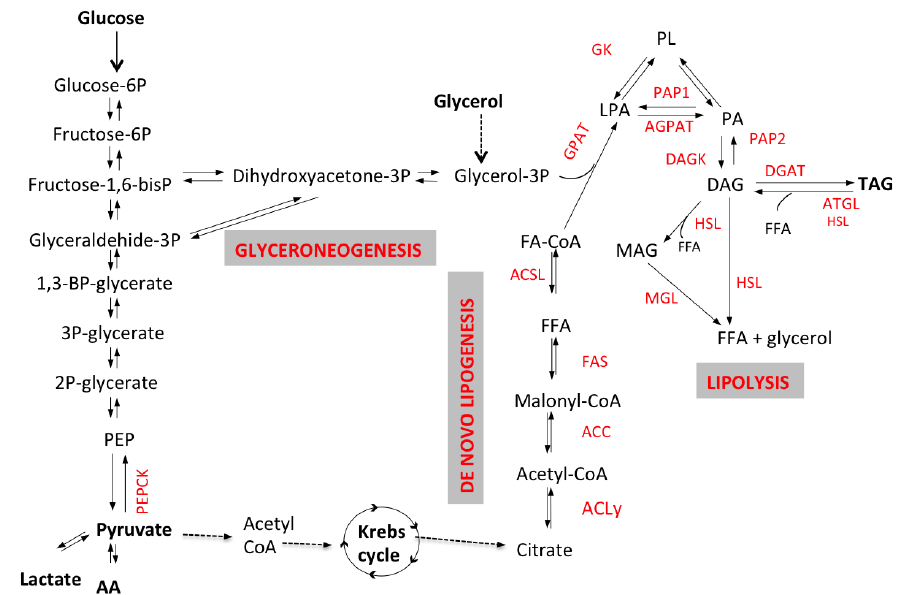
Figure 1. Schematic representation of lipolytic and lipogenic pathways. Triacyglycerol (TAG) synthesis requires the activation of free fatty acids (FFA) into Acyl-CoA by enzyme acyl-CoA synthetase. FFA-CoA and G3P are transformed via acylation, by glycerol-3-phosphate acyltransferase (GPAT) and acylCoA acylglycerol-3-phosphate acyltransferases (AGPAT), to phosphatidic acid (PA); then, after a dephosphorylation by phosphohydrolase (PAP2), diacylglycerols (DAG) are formed. Diacylglycerol acyltransferase (DGAT) catalyzes the conversion of DAG into TAG. In the adipocyte, G3P might come either from glycolysis or from non-carbohydrate substrates via the enzyme phosphoenolpyruvate carboxykinase (PEPCK), through a process named glyceroneogenesis. In the liver G3P can also be synthesized from plasma glycerol. De novo fatty acids synthesis (also referred to as de novo lipogenesis or DNL) occurs in the cytoplasm of various cells (e.g., adipocytes and hepatocytes) where citric acid is converted to acetyl-CoA by ATP-citrate lyase (ACL) and subsequently to malonyl-CoA by acetyl-CoA carboxylase (ACC). DNL occurs mainly in the liver, but it might occur in adipose tissue as well, although with low rates. This process requires the two enzymes ATP-citrate lyase (ACL), acetyl-CoA carboxylase (ACC) and the multi-enzymatic complex fatty acid synthase (FAS). G3P can be synthesized directly from non-carbohydrate substrates such as pyruvate, lactate or amino acids in oxaloacetate, that is converted to G3P either directly from phoenolpyruvate (PEP), via the key enzyme phosphoenolpyruvate carboxykinase (PEPCK), or through synthesis of dihydroxyacetone (DHA). TAG catabolism ( i.e. , lipolysis) involves several lipases, adipose triglyceride lipase (ATGL), hormone-sensitive lipase (HSL) and monoacylglycerol lipase (MGL) and produces the release of three free fatty acids (FFA) and one glycerol